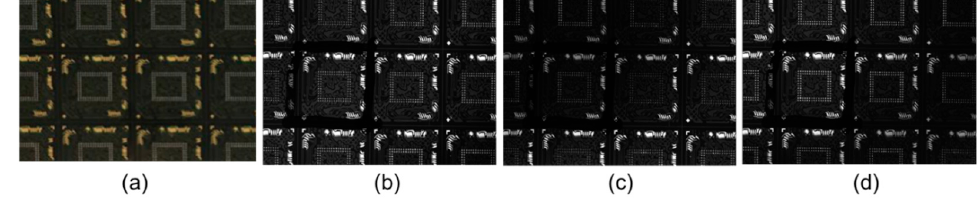
Figure 7. Example measurement of a BGA sample: ( a ) photograph of the BGA sample, ( b ) I _ {0}, ( c ) I {2 π /3}, and ( d ) I {4 π /3}.